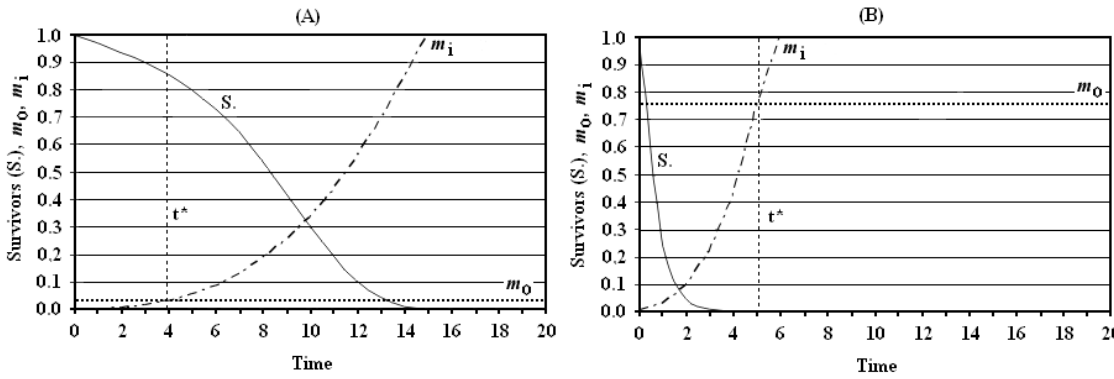
FIGURE 8 . (A) Life table of Panthera leo ( m 0 = 0.032; α = 0.000252; β = 3). (B) Life table of Parus major (M) ( m 0 = .756; α = .00343; β = 3). In both cases, data are from [2], and figures illustrate life tables and the values of m 0 and of m i . The dashed vertical lines indicate the time t* when m i becomes greater than m 0